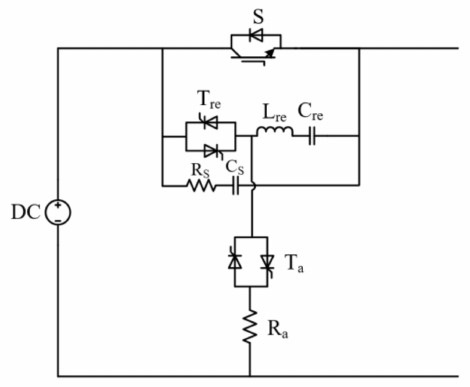
Figure 9. LC resonance CB.